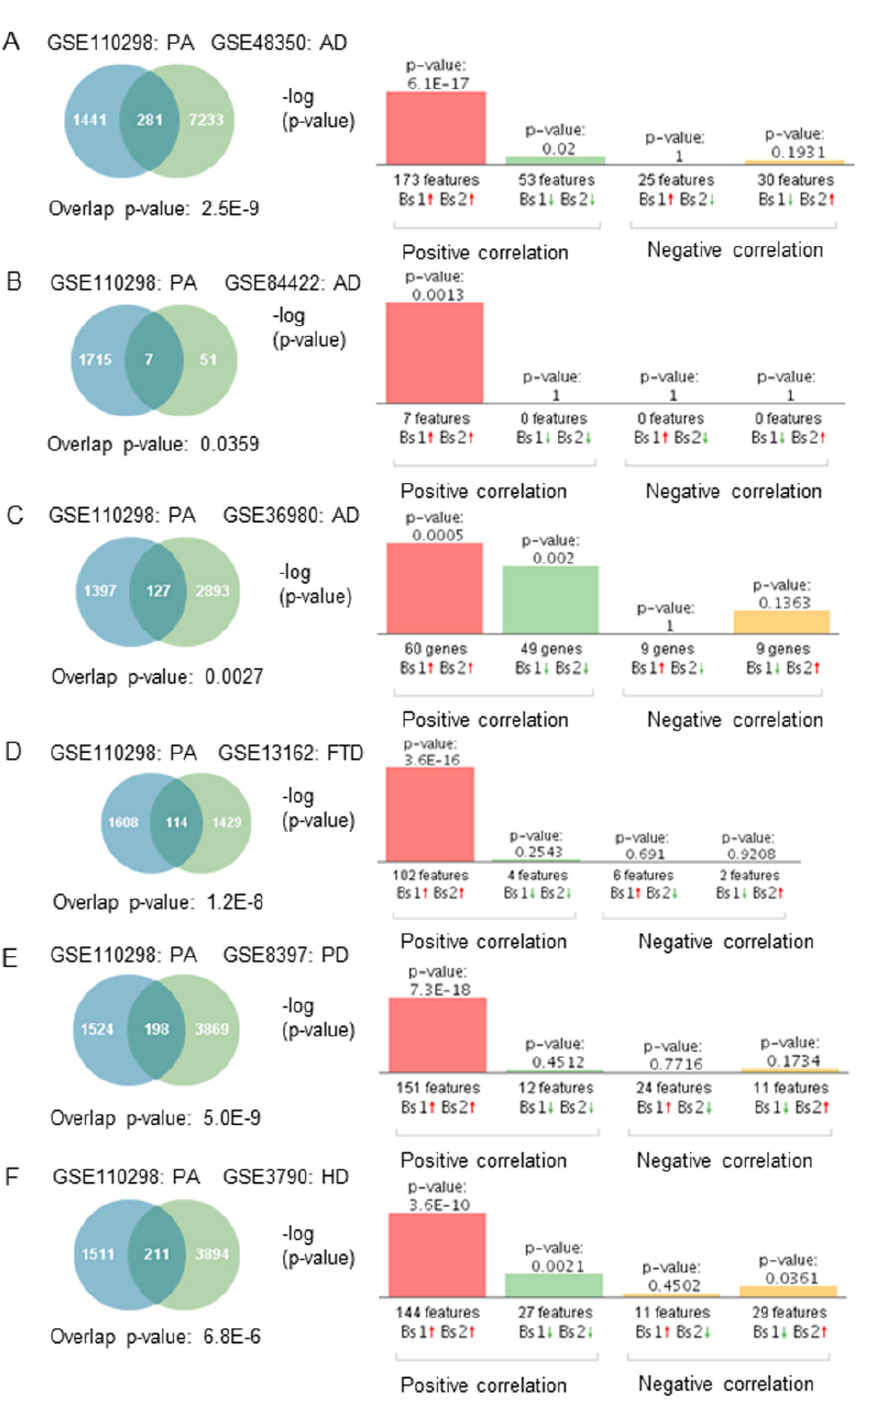
Figure 4. Genetic overlap and correlation analysis between subjects who engaged in low physical activity and patients with neurodegenerative diseases. Venn diagram and correlation analyses of shared genes between physically active (PA) subjects in GSE110298 and ( A ) AD GSE48350, ( B ) AD GSE84422, ( C ) AD GSE36980, ( D ) FTD-GRN(+) GSE13162, ( E ) PD GSE8397, ( F ) HD GSE3790. Vertical bars represent the significance of the overlap and the correlations between the datasets. Red and green arrows denote up and downregulation, respectively. p -value is expressed as the –log10 of the p -value. Statistical significances regarding the genetic overlap and the directionality of the fold changes were derived from the non-parametric ranking method used by Base Space Correlation Engine (Illumina, Inc., San Diego, CA,